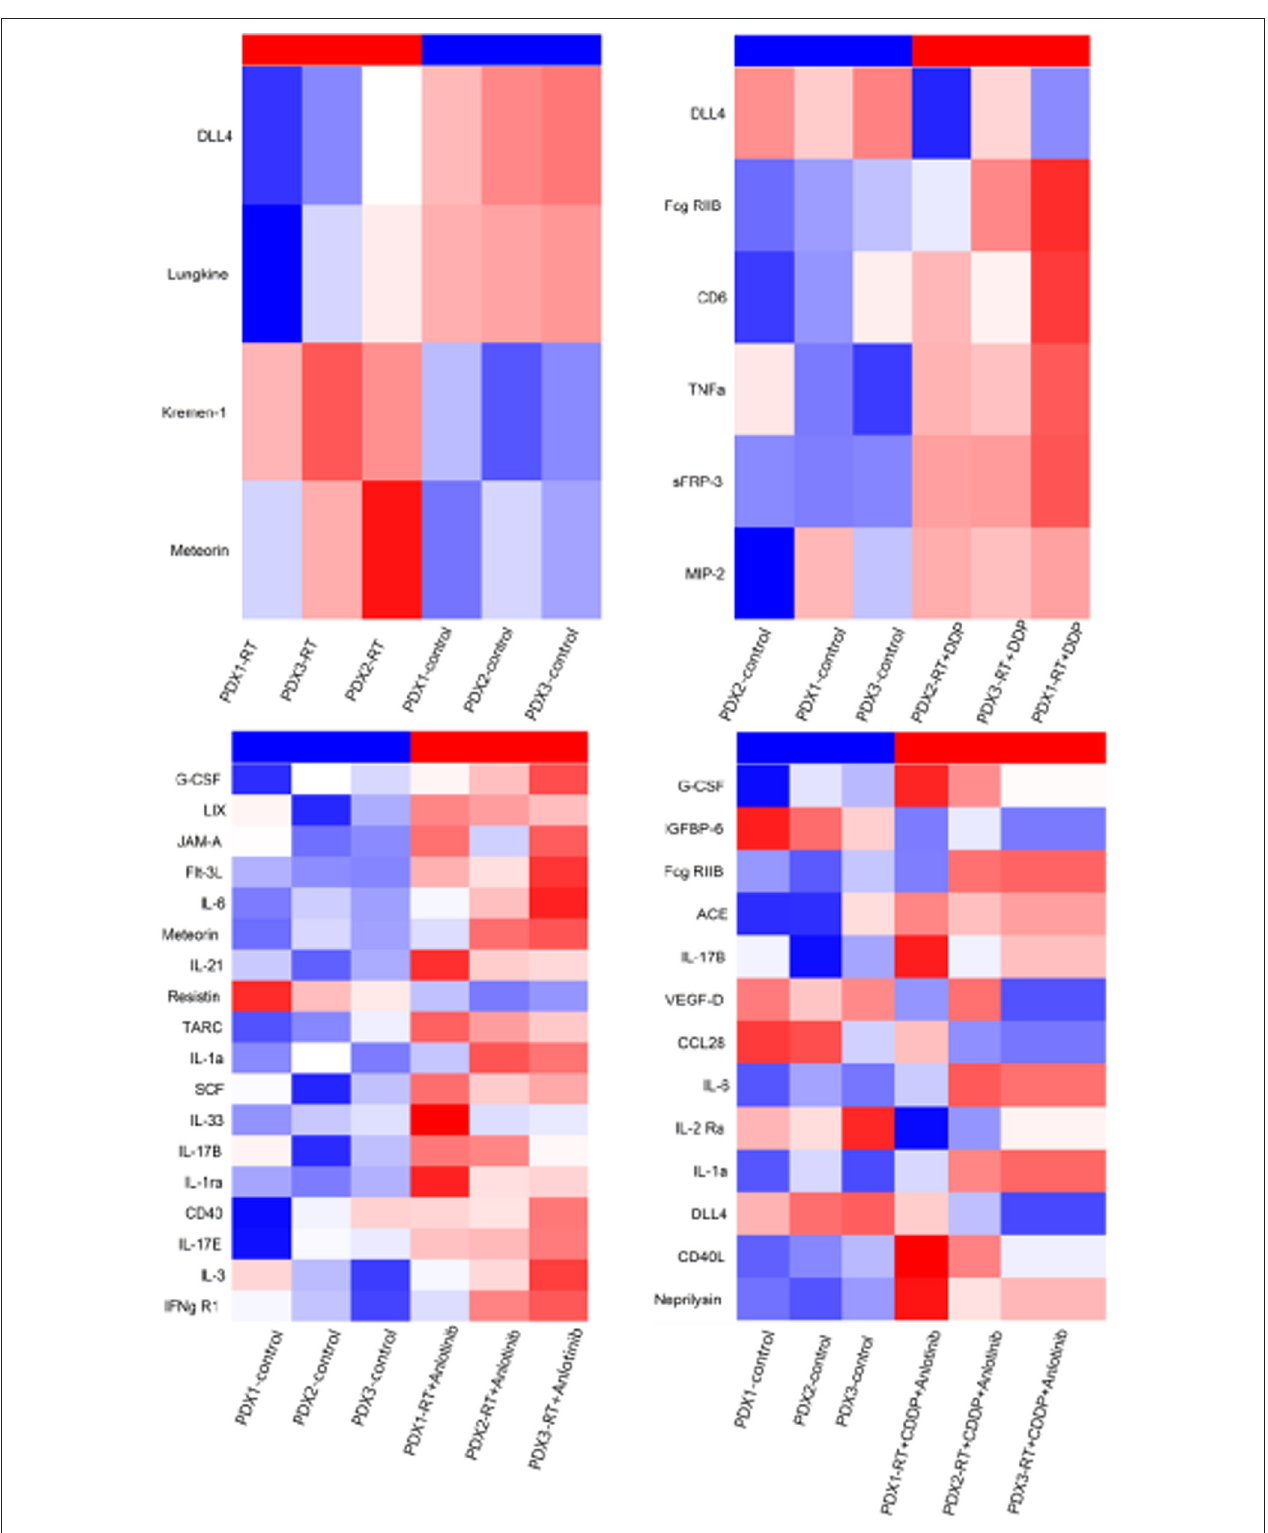
FIGURE 13 | Heatmaps show the released cytokines in plasma from four treatment groups compared with control group. RT, radiation therapy; DDP, cisplatin.